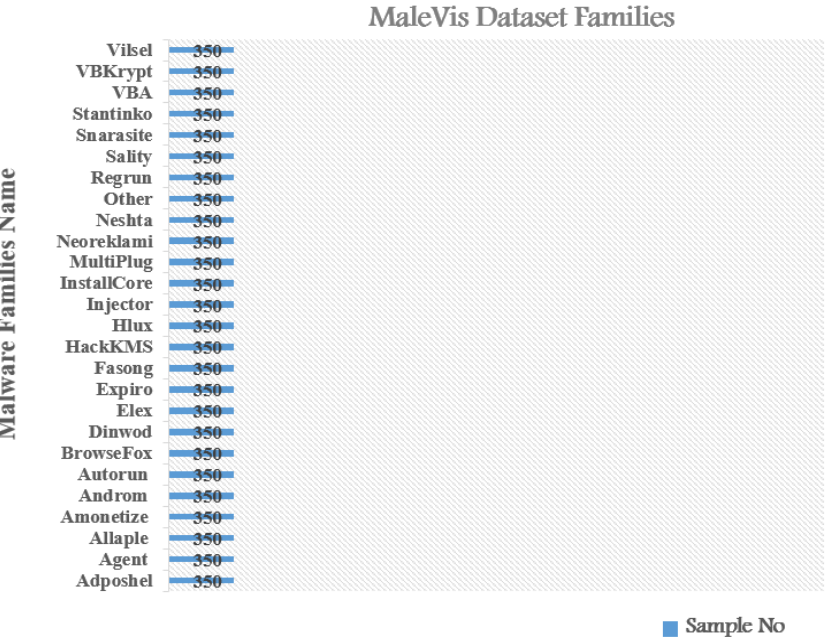
Figure 6. The distribution of MaleVis datasets samples among different malware classes.